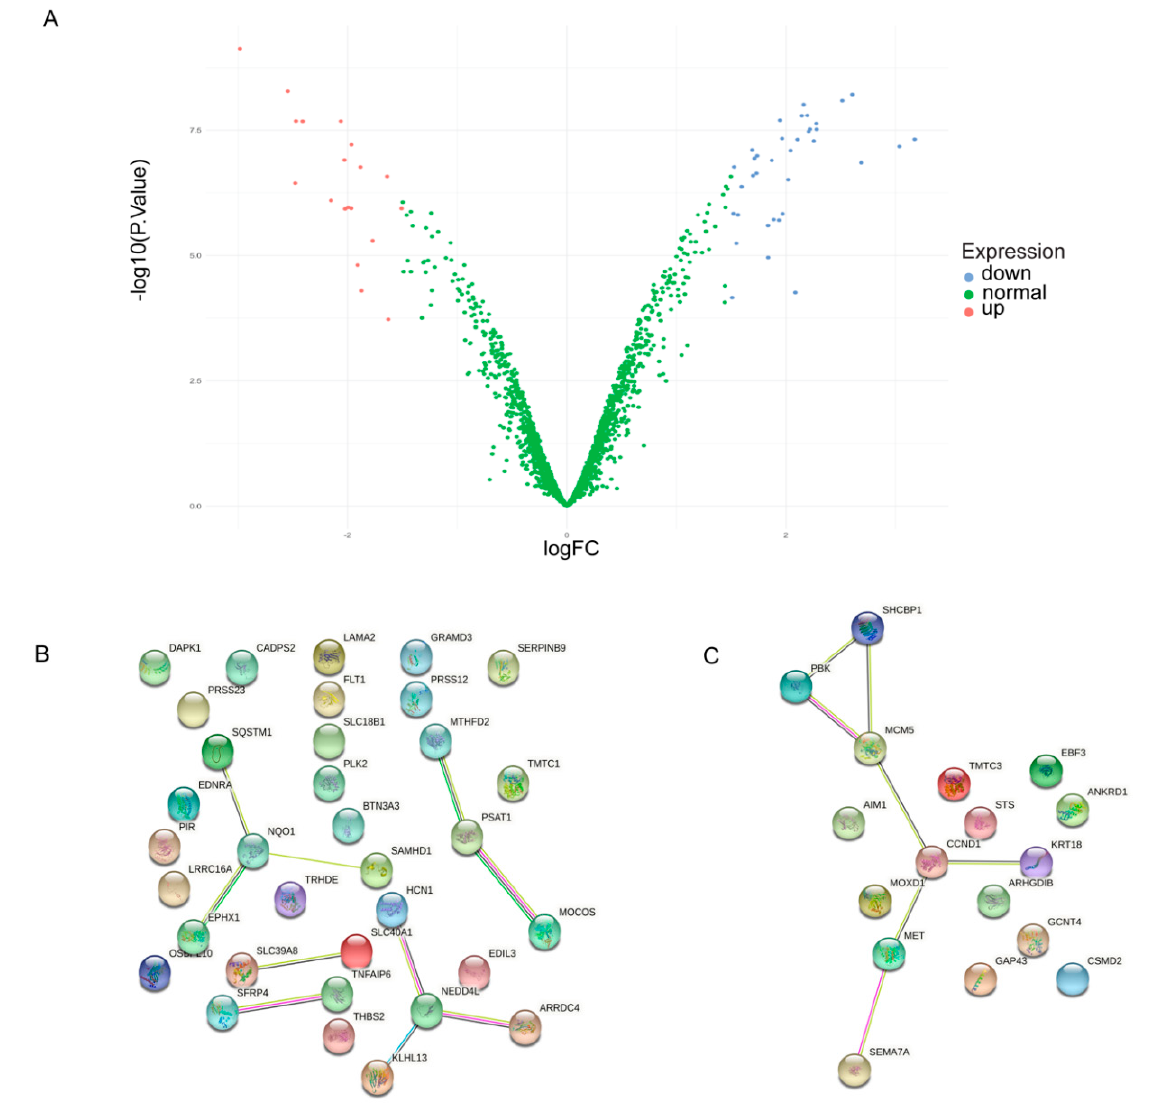
Figure 7. ( A ) Volcano plot showing the amount of significantly up, red, and down, blue, regulated fibroblast genes out of the lavenderblush module. String plots of down and up regulated genes from the parental fibroblasts from the MT dataset. ( B ) Downregulated genes in RTT fibroblasts samples (MT) belonging to the lavenderblush module. ( C ) Upregulated genes in RTT fibroblasts. Note: The OH and TK datasets did not include fibroblast gene expression data. Table 3. Descriptions of the four genes related to ubiquitination (KLHL13, NEDD4L, ARRDC4 and HCN1) that are down- regulated in RTT fibroblasts (information from UniProt).